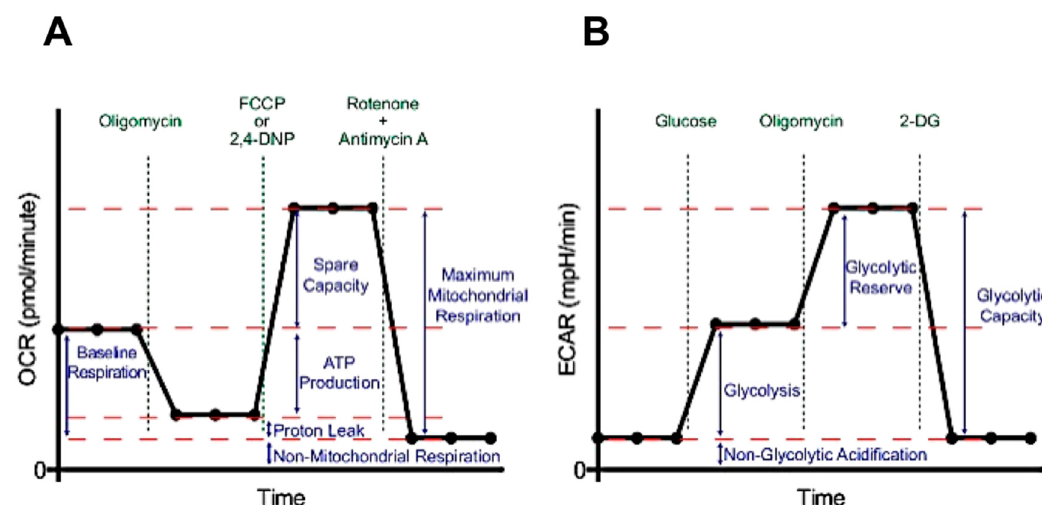
Figure 2. Representative outcome of the metabolic flux analysis protocol. ( A ) Oxygen consumption rate (OCR) was first measured under routine condition (baseline respiration), and then its changes following the sequential additions of oligomycin, carbonyl cyanide p-trifluoromethoxyphenylhydrazone (FCCP), rotenone + antimycin A; the bioenergetic parameters inferred from the comparison of the different OCR attained are shown. ( B ) Extracellular acidification rate (ECAR) was first measured in a buffer without glucose, and then its changes following the sequential addition of glucose, oligomycin, and 2-deoxyglucose (2-DG); the glycolytic parameters inferred from the comparison of the di ff erent ECAR attained are